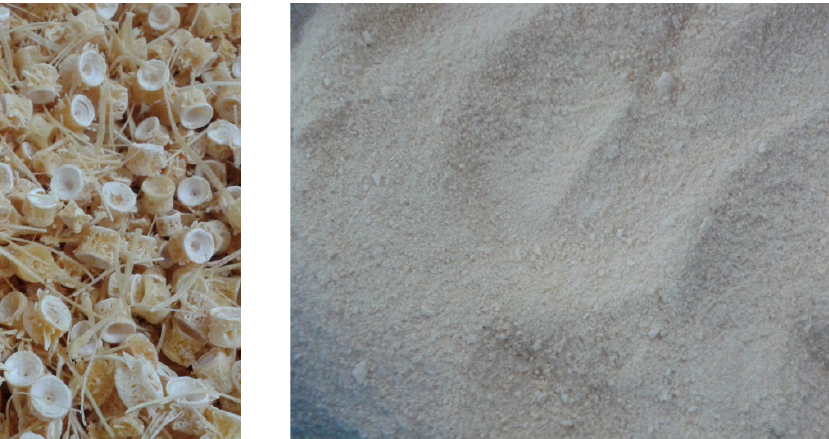
Figure 5: Bone product from salmon backbones after processing and drying.